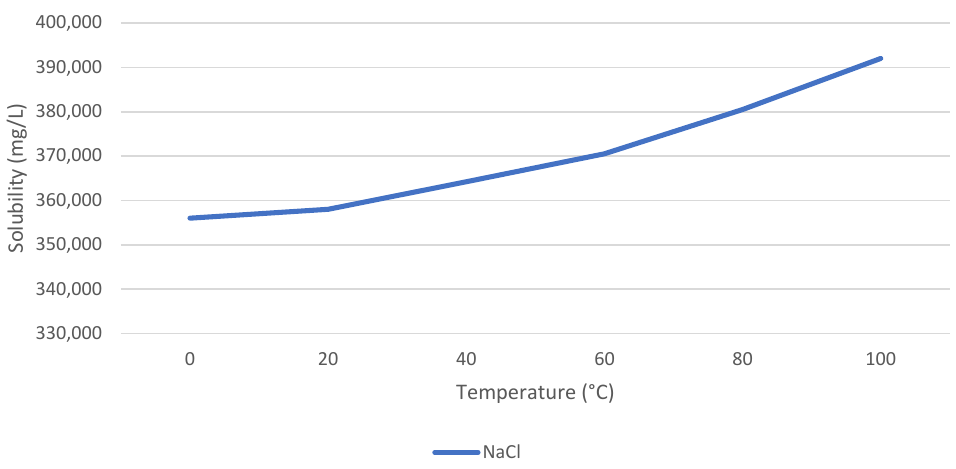
Figure 1. Influence of temperature on the solubility of NaCl [26].